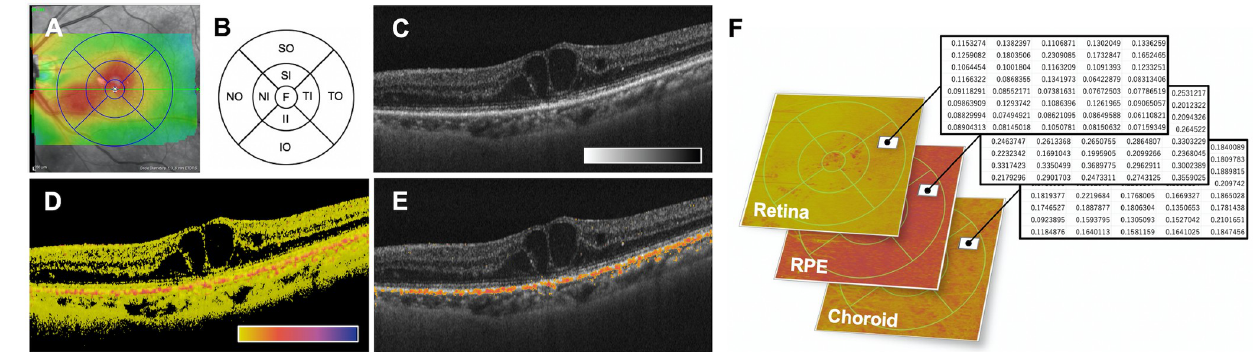
Fig 2. Representative SD-OCT (A), ETDRS grid (B), and PS-OCT images (C-F). (A) En face macular map with the ETDRS grid obtained using SD-OCT. (B) The ETDRS grid was used to demarcate nine zones delimited by solid circles with diameters 1 mm, 3 mm, and 6 mm meter centered on the fovea. (C) Intensity B-scan image [color scale: = 45 to 80 dB]. (D) Entropy B-scan image [color scale: entropy of 0 to 1]. Pixels below the detection threshold of the OCT intensity are displayed in black. (E) Overlapped with signalized entropy B-scan image (set as > 0.1) on intensity OCT image. (F) En face entropy map of each segmented layer (512 × 512 pixels, each) and the numeral tables, which present entropy values at each pixel location, are shown. Abbreviations in (B) are shown in the following order; TI, temporal inner; II, inferior inner; NI, nasal inner; SI, superior inner; TO, temporal outer; NO, nasal outer; SO, superior